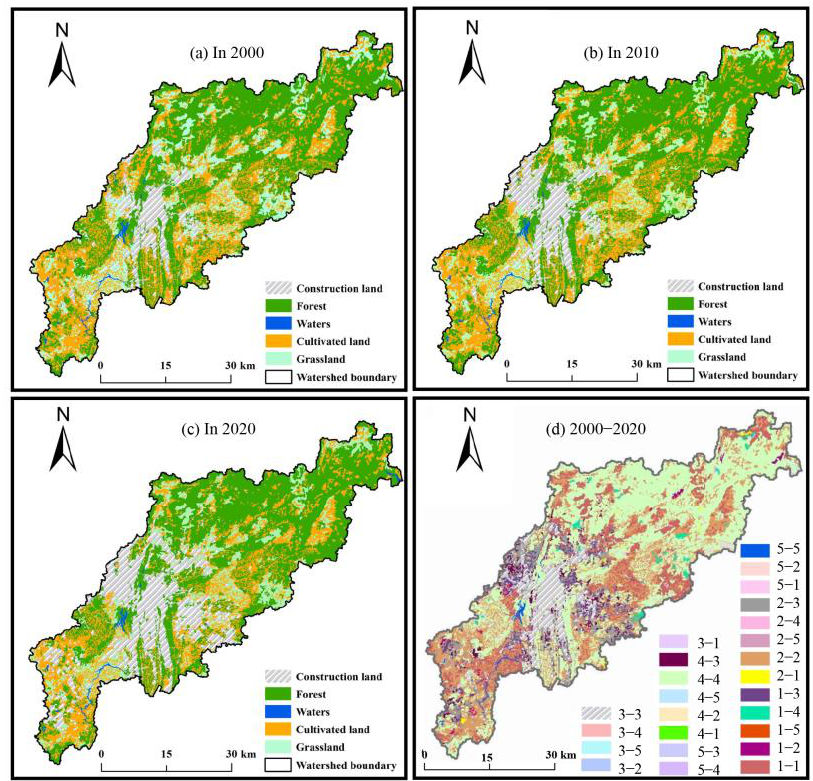
Figure 4. Land use status map of the study area in 2000 ( a ), 2010 ( b ), 2020 ( c ), and land use transfer map from 2000 to 2020 ( d ). Note: 1 indicates grassland; 2 indicates cultivated land; 3 indicates constructed land; 4 indicates forest; and 5 indicates waters.